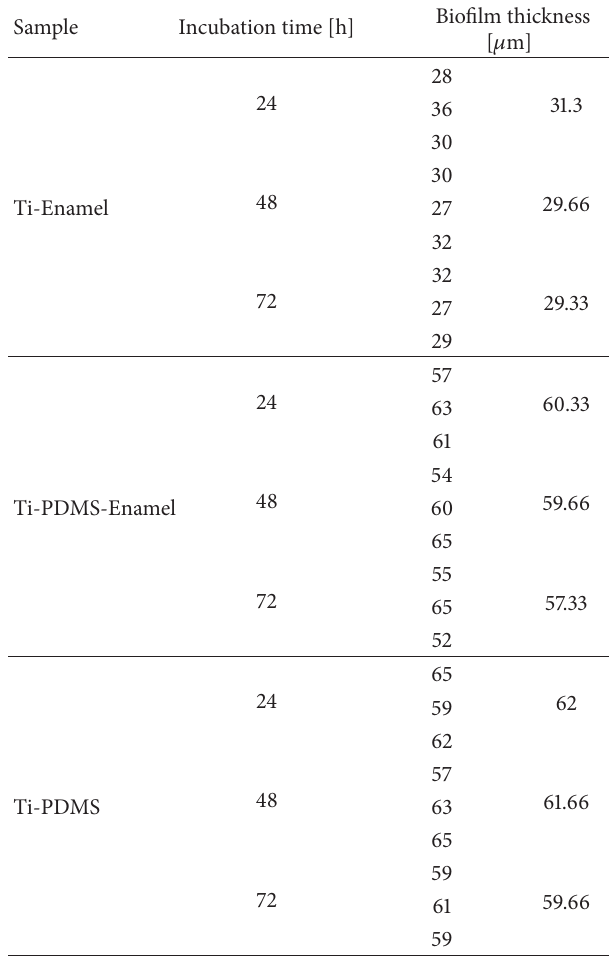
Table 2: Thickness of C. albicans biofilms developed on the surface of Ti-Enamel, Ti-PDMS-Enamel, and Ti-PDMS layers at 24, 48, and 72